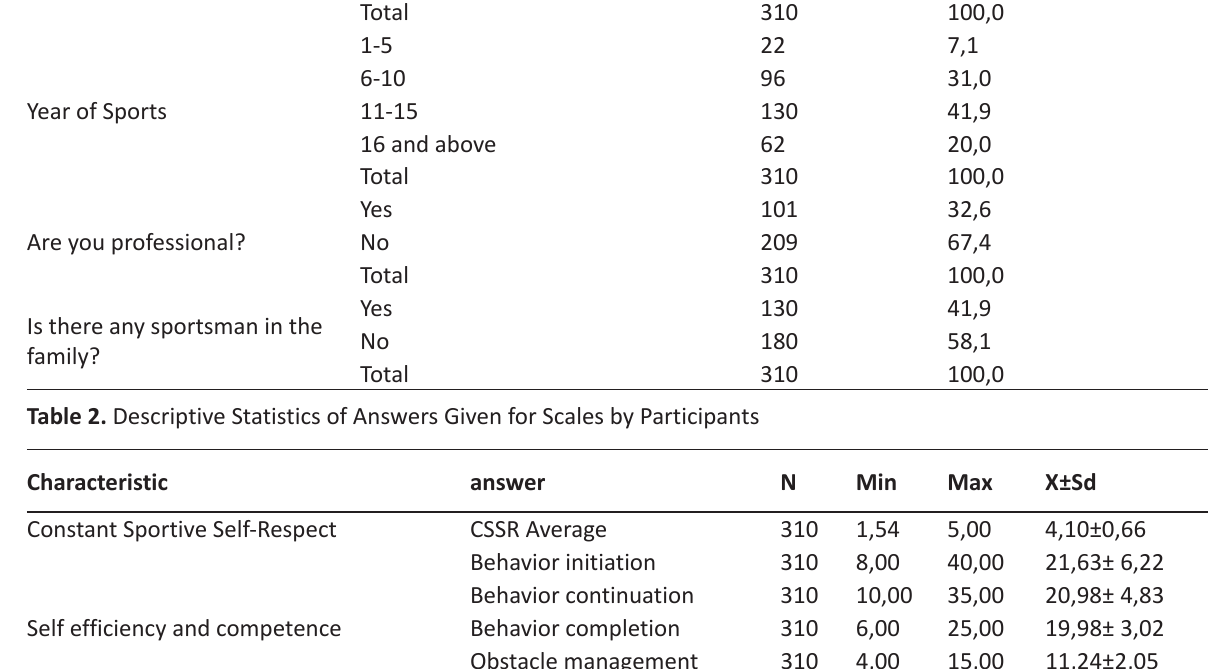
Self efficiency and competence